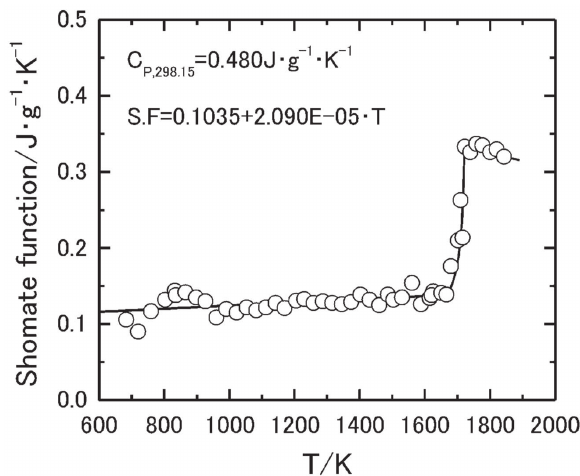
Figure 5. Temperature dependence of Shomate function for